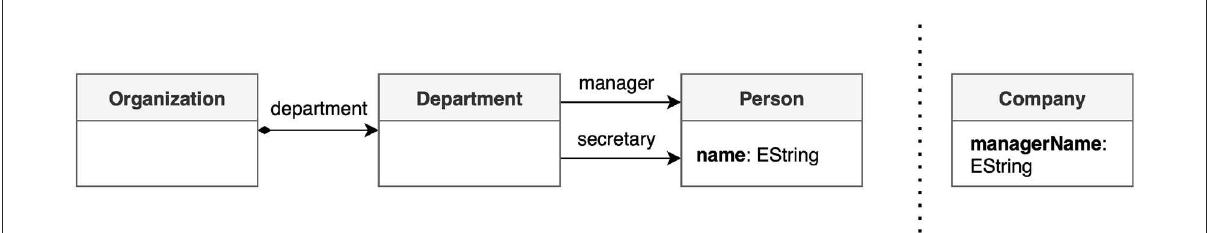
FIGURE3 Ambiguous navigation.